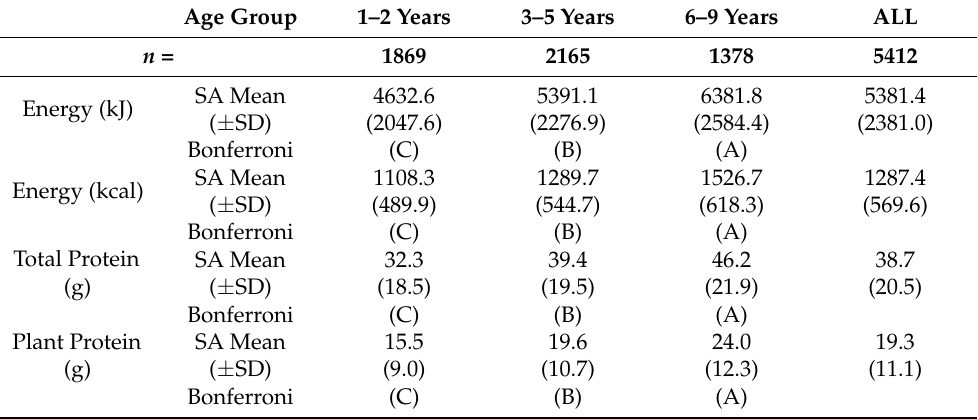
Table A1. South African child mean ± SD intake of energy and macronutrients by PDIS age